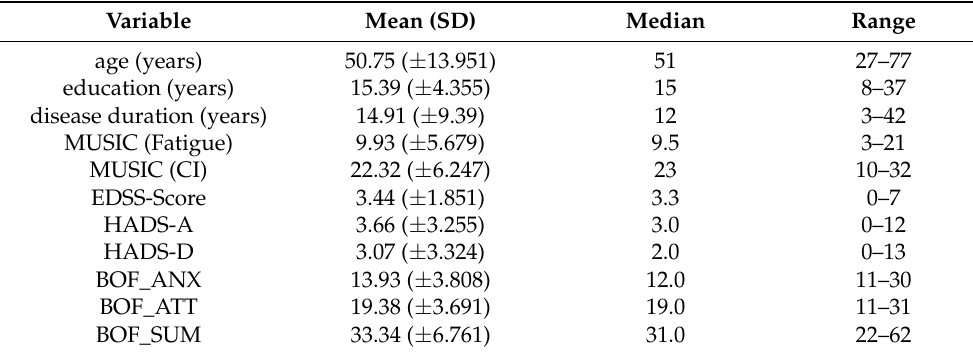
Table 1. Descriptive Statistics of Demographic and Clinical Variables (N =